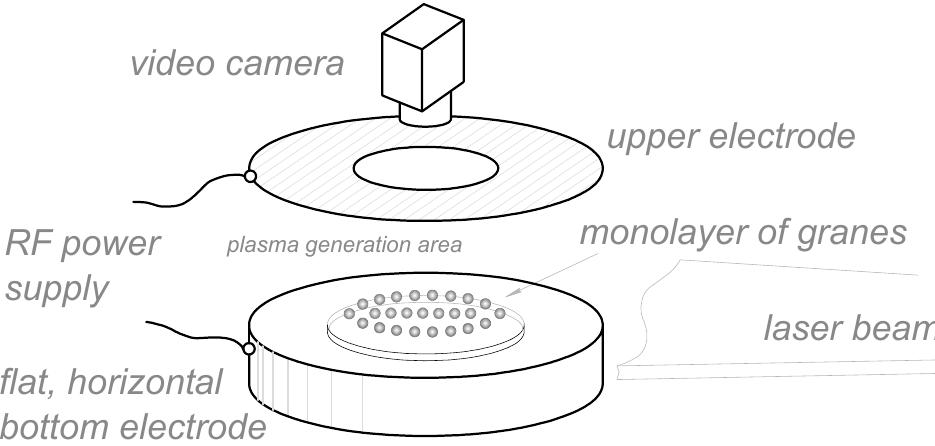
Figure 11. A scheme of an experimental setup. After that, melamine–formaldehyde (MF) grains with a diameter of d = 10.6 µ m